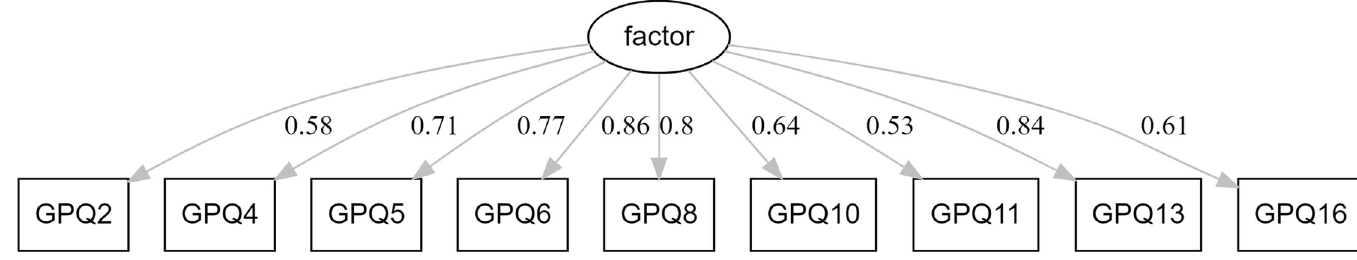
Fig 2. Standardized solution of the GPQ9 one-factor model in a Polish sample.